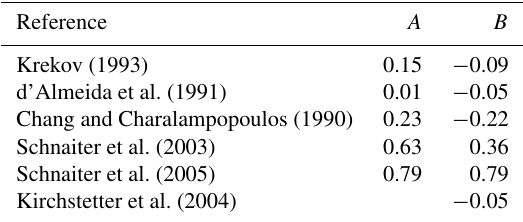
Table 1. Fitted values for the parameters A and B used to define the spectral variation in BC refractive indices.